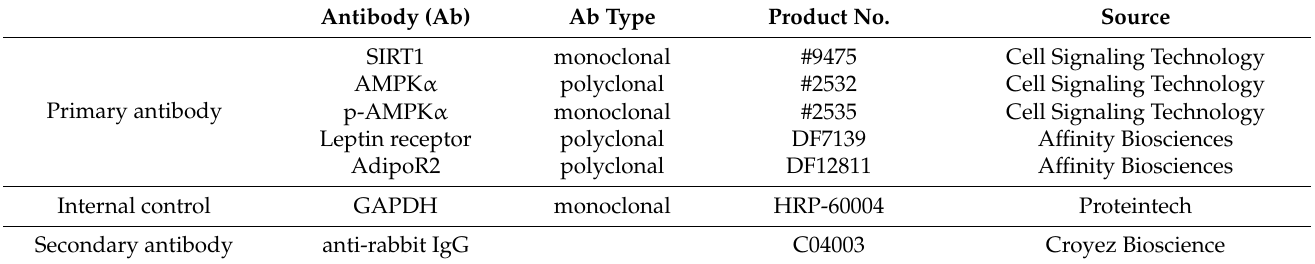
Table 9. Antibodies used for Western